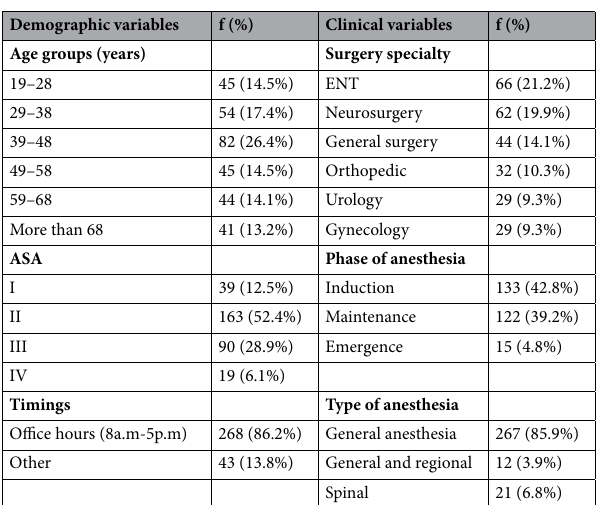
Table 1. Demographic and clinical